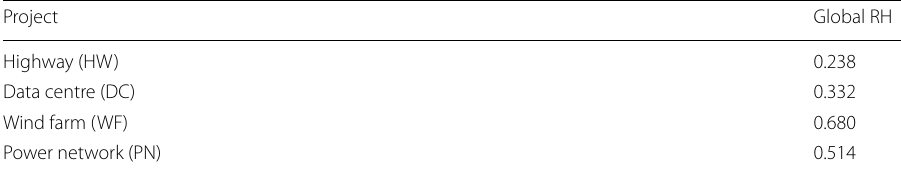
The comparison with Fig. 1 shows a correspondence between higher score values and longer tail in the ancestry tree size distribution